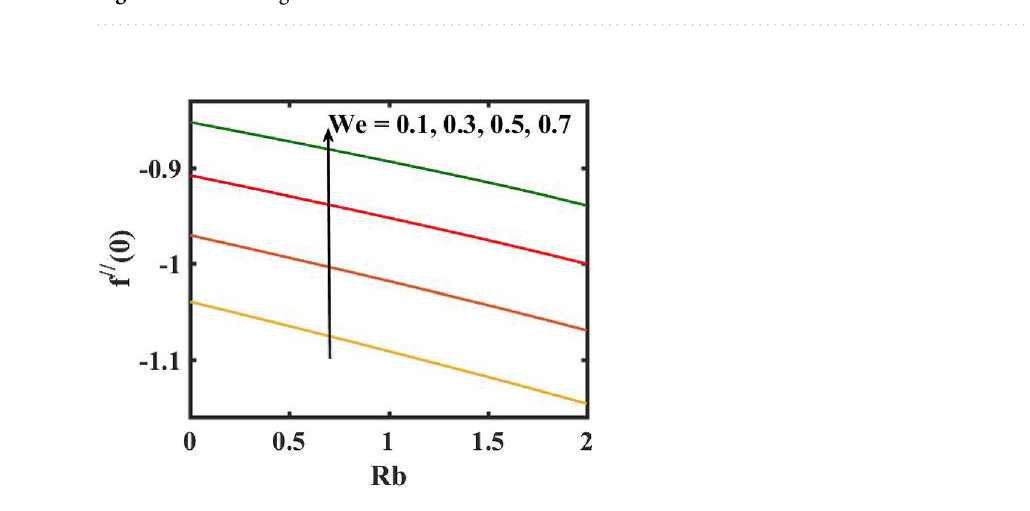
Figure 18. Encouragement of M and (cid:31) . on skin friction coefficient.